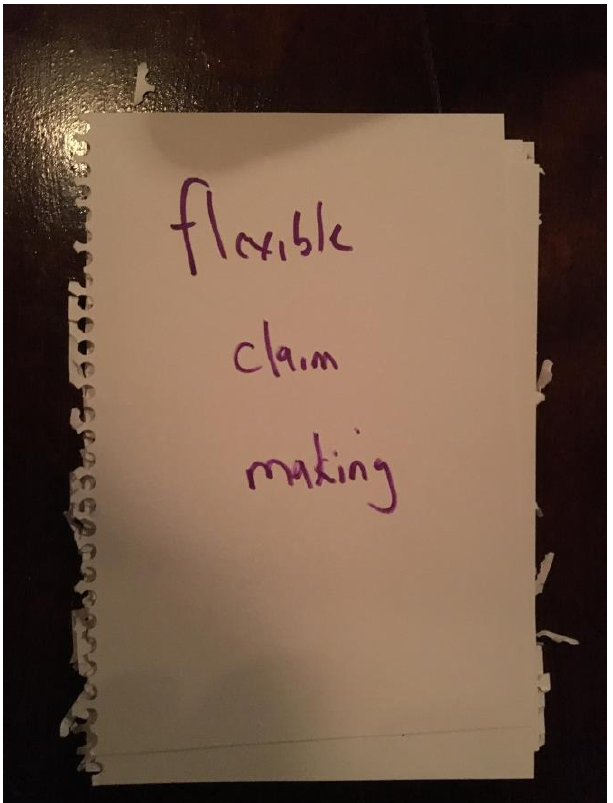
FIGURE 3: ONE OF MY OWN POETIC REFLECTIONS, TORONTO